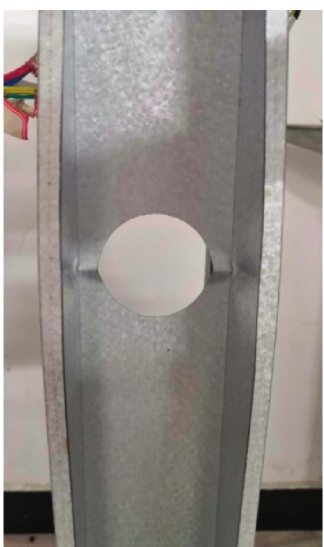
Figure 12: Plastic local buckling failure of plates adjacent to holes.